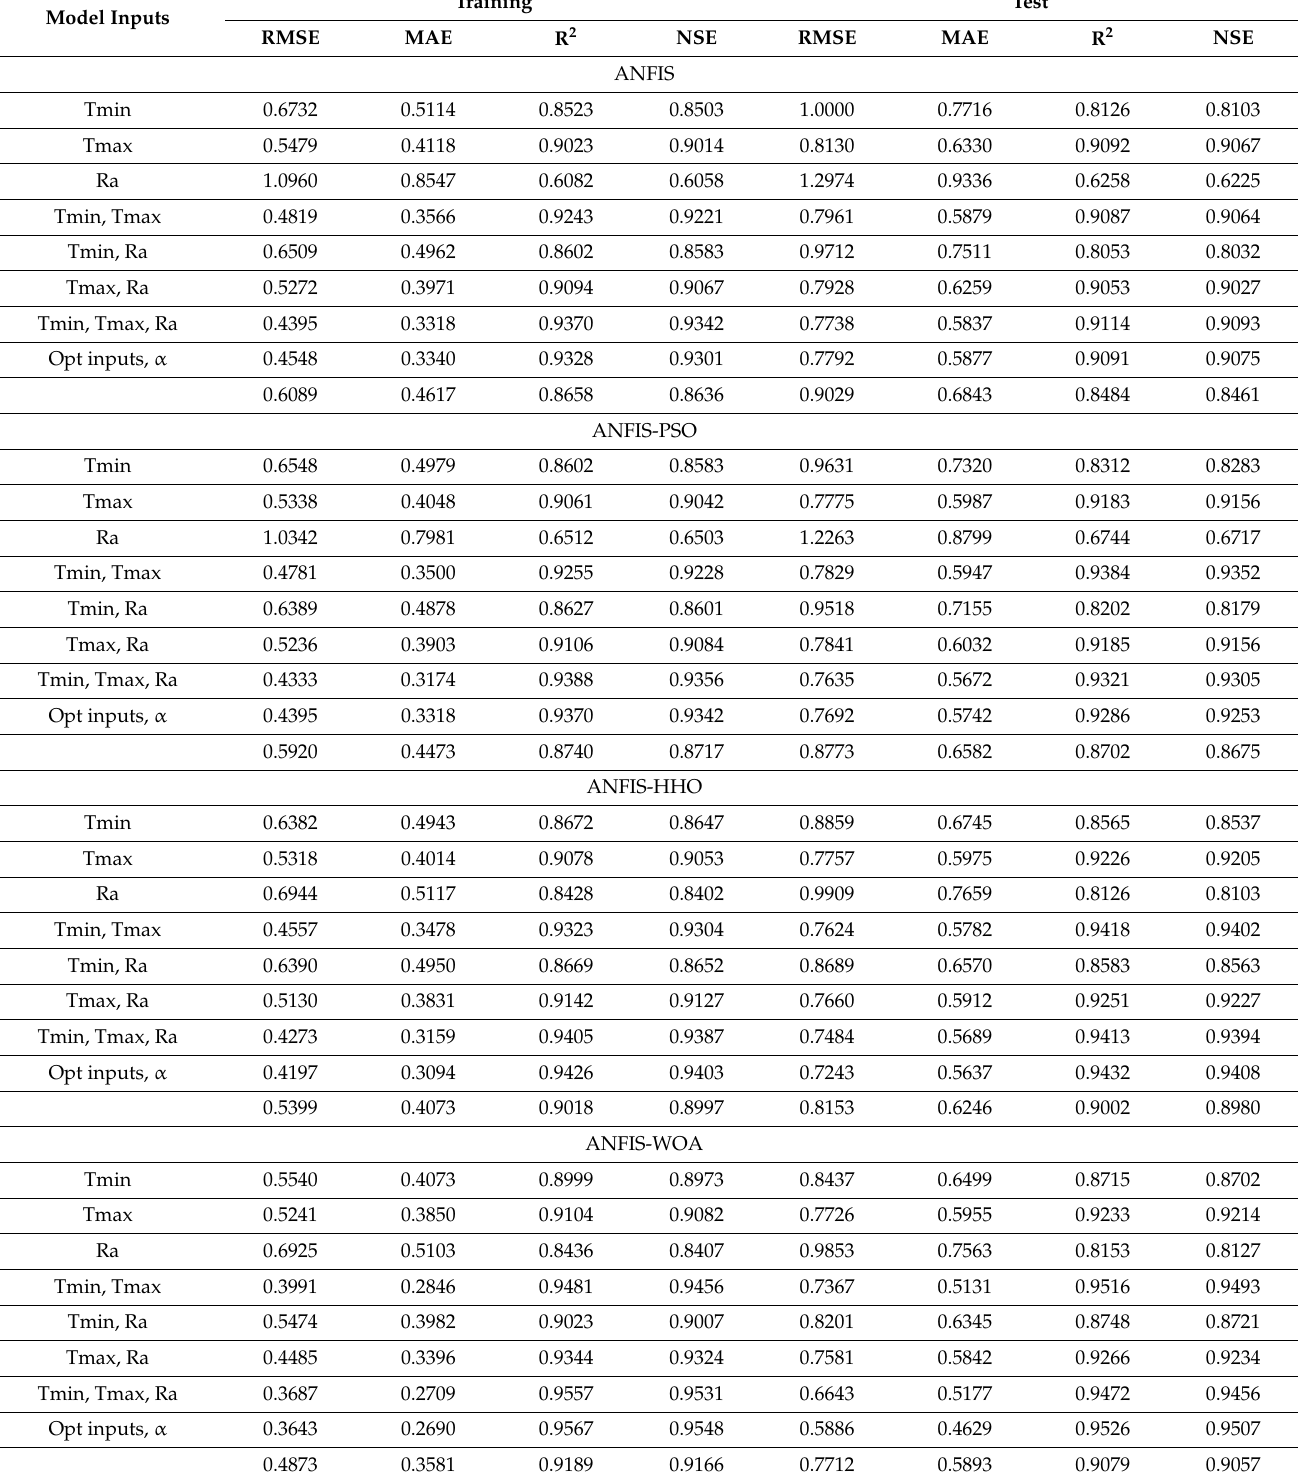
Table 5. Training and testing performances of the models for monthly Epan prediction—Nanxian